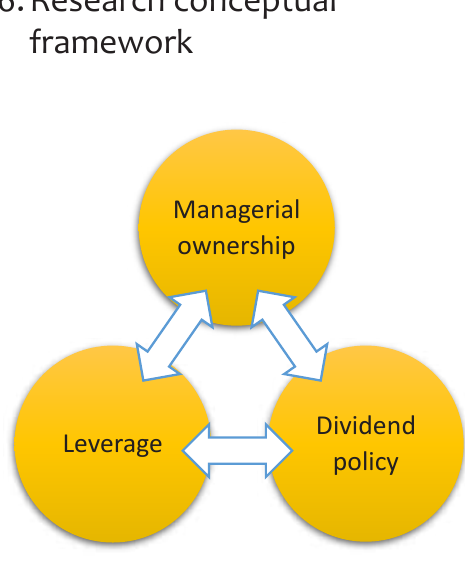
Figure 1. Research conceptual